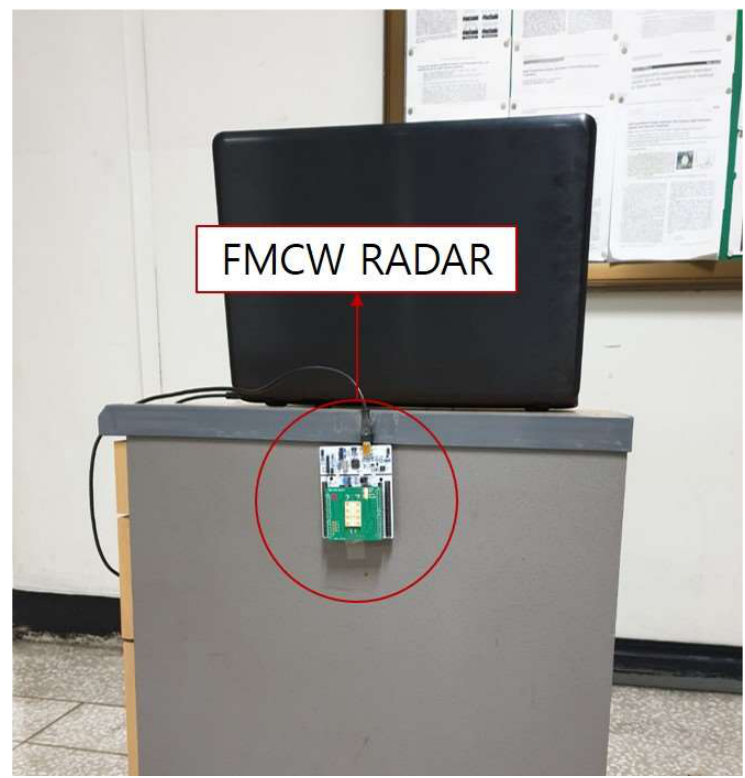
Figure 3. FMCW radar used in experiments.